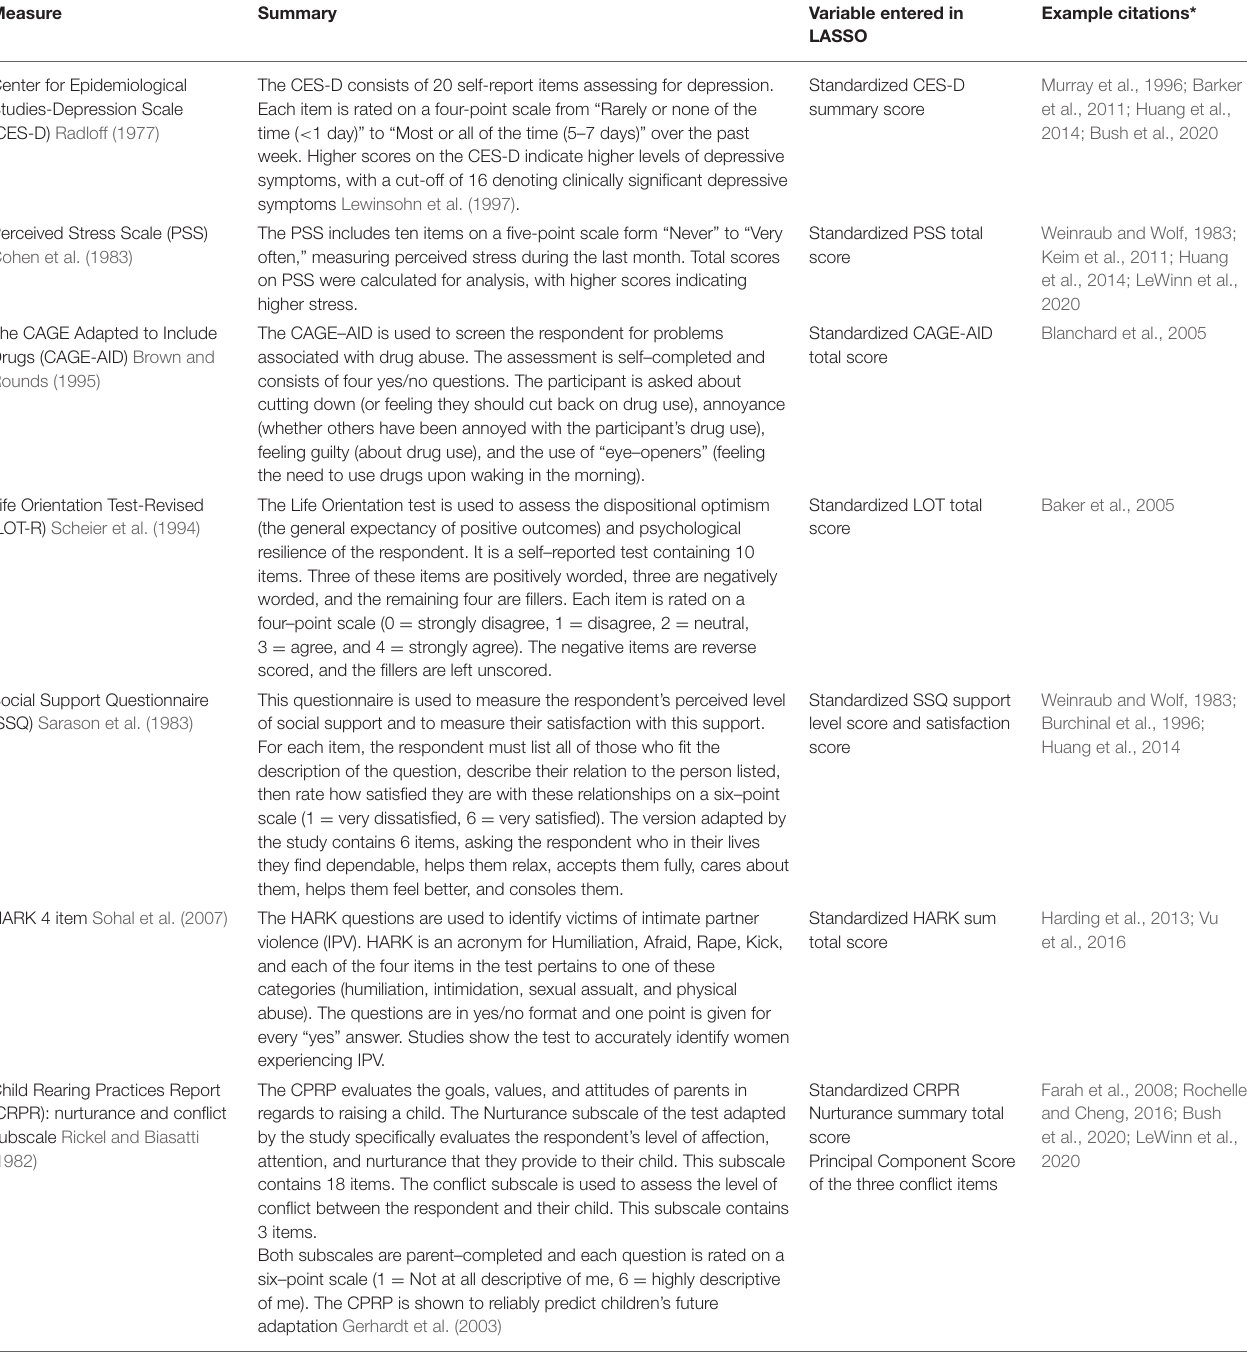
TABLE 2 | Description of exposure measures